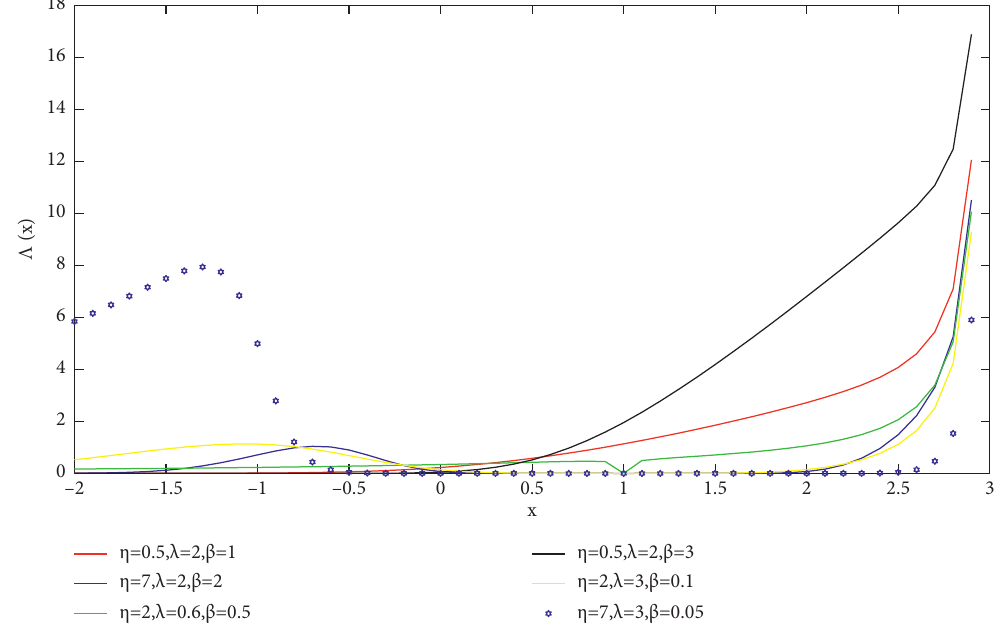
Figure 3: The hazard plots of B G Γ M for a � − 2, b � 3, u � 1, δ � 1 and different values of β , η and λ